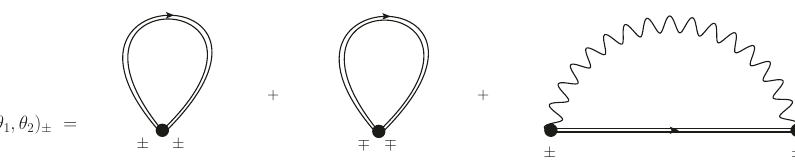
Figure 1 . Integral equation for self-energy. The double lines indicate the exact propagator. (cid:6) (cid:6) is the self-energy correction for the scalar super(cid:12)eld (cid:8) (cid:6) . The (cid:12)rst diagram on the r.h.s. is the contribution from the vertex ((cid:22)(cid:8) (cid:6) (cid:8) (cid:6) ) 2 , the second contribution is from the vertex ((cid:22)(cid:8) + (cid:8) + )((cid:22)(cid:8) (cid:0) (cid:8) (cid:0) ), while the last diagram is the contribution from the gauge super(cid:12)eld exchange. The (cid:6) symbols denote the R -charge of the external